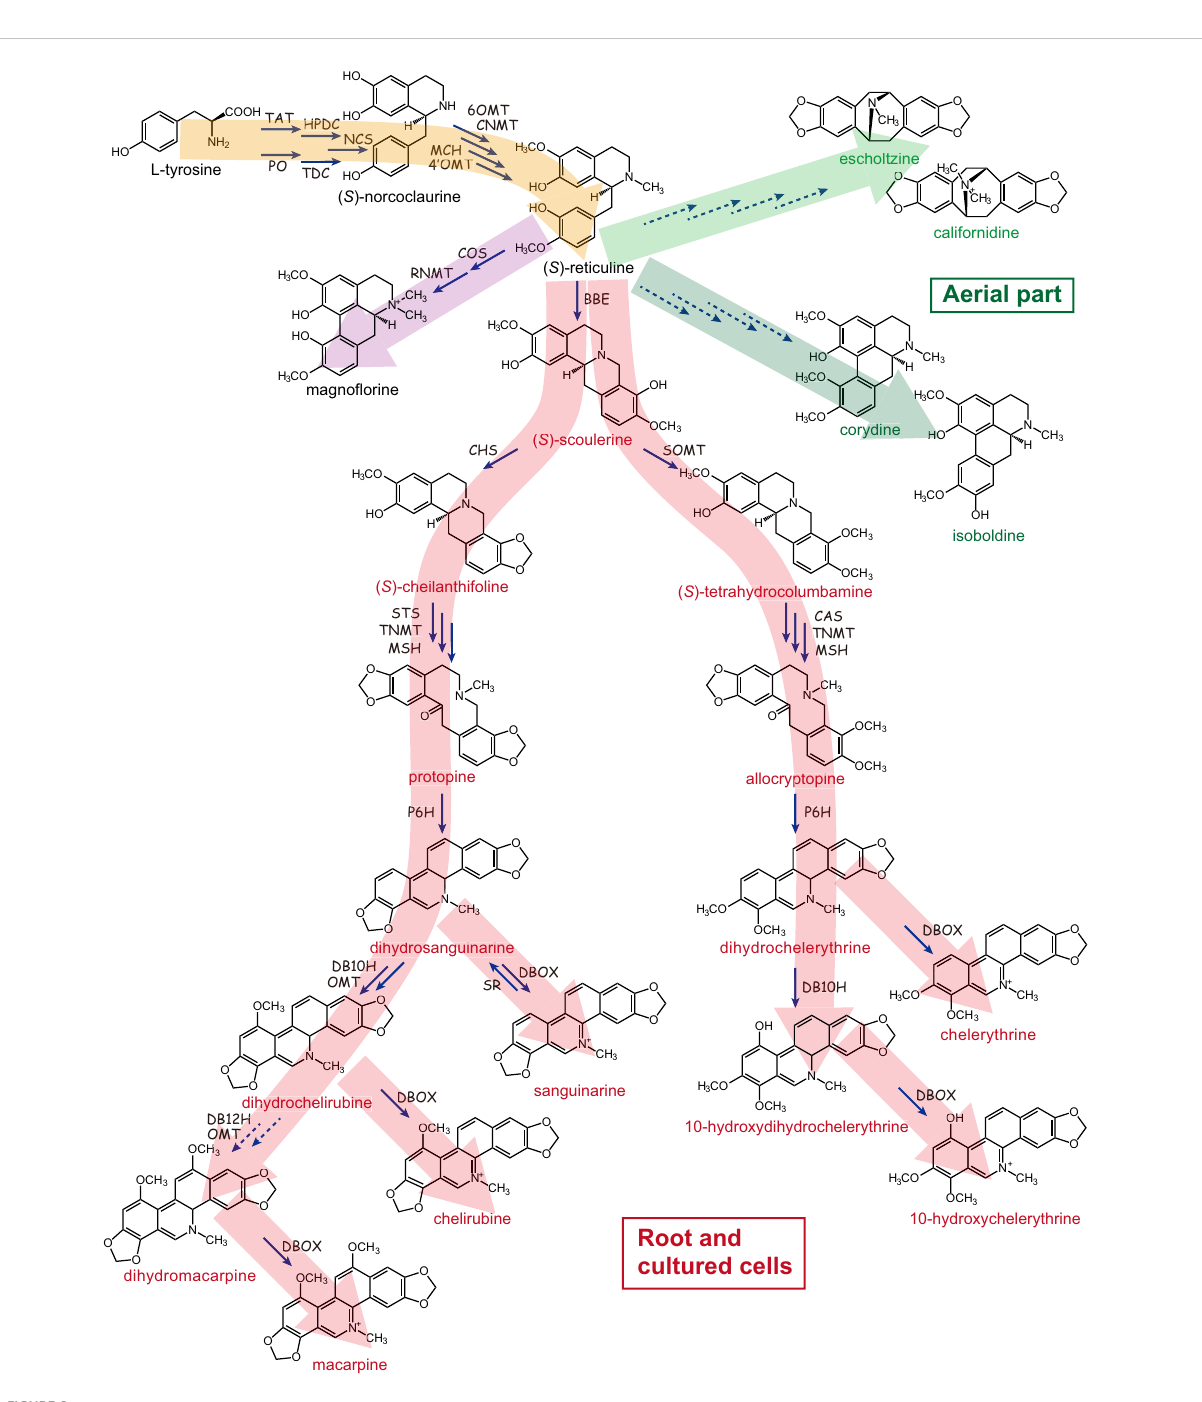
FIGURE 2 Benzylisoquinoline alkaloid biosynthetic pathway in California poppy. California poppy produces diverse array of benzylisoquinoline type alkaloids (BIAs), which include benzophenanthridine alkaloids (such as sanguinarine, chelirubine, macarpine, chelerythrine, chelilutine), protopines (protopine, allocryptopine), aporphine alkaloids (magno fl orine, corydine, isoboldine), simple benzylisoquinolines (reticuline), pavine alkaloids (californidine, escholtzine), as well as the dihydro-intermediates. The broken lines indicate that the biosynthetic enzyme-encoding genes have not been identi fi ed. TAT, tyrosine aminotransferase; HPDC, p -hydroxyphenylpyruvate decarboxylase; PO, phenol oxidase; TDC, tyrosine/DOPA decarboxylase; NCS, ( S )- norcoclaurine synthase; 6OMT, ( S )-norcoclaurine 6- O -methyltransferase; CNMT, ( S )-coclaurine N -methyltransferase; MCH, ( S )- N -methylcoclaurine 3 ’ -hydroxylase; 4 ’ OMT, ( S )-3 ’ -hydroxy- N -methylcoclaurine 4 ’ - O -methyltransferase; COS, ( S )-corytuberine synthase; RNMT, ( S )-reticuline N - methyltransferase; BBE, berberine bridge enzyme; SOMT, ( S )-scoulerine 9- O -methyltransferase; CHS, ( S )-cheilanthifoline synthase; STS, ( S )-stylopine synthase; CAS, ( S )-canadine synthase; TNMT, ( S )-tetrahydroprotoberberine N -methyltransferase; MSH, ( S )- N -methylstylopine 14-hydroxylase; P6H, protopine 6-hydroxylase; DBOX, dihydrobenzophenanthridine alkaloid oxidase; SR, sanguinarine reductase; DB10H,